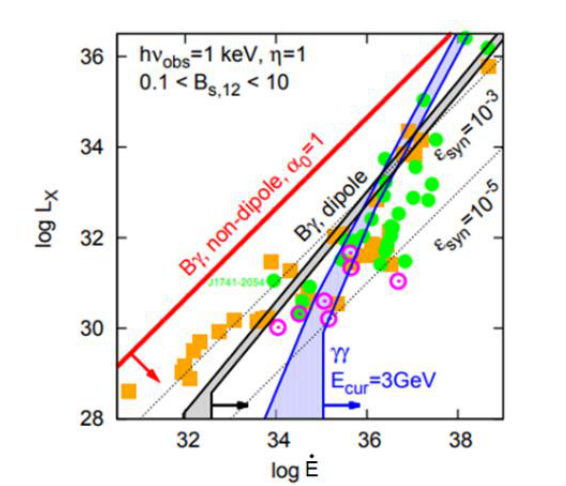
Figure 4. Maximum luminosities of synchrotron radiation in 1 keV (upper) and 1 eV (lower) for two-photon collision case (γγ, blue), magnetic pair creation cases (Bγ) with dipole field (black) and non-dipole fields (red) as a function of the spin-down luminosity L sd .